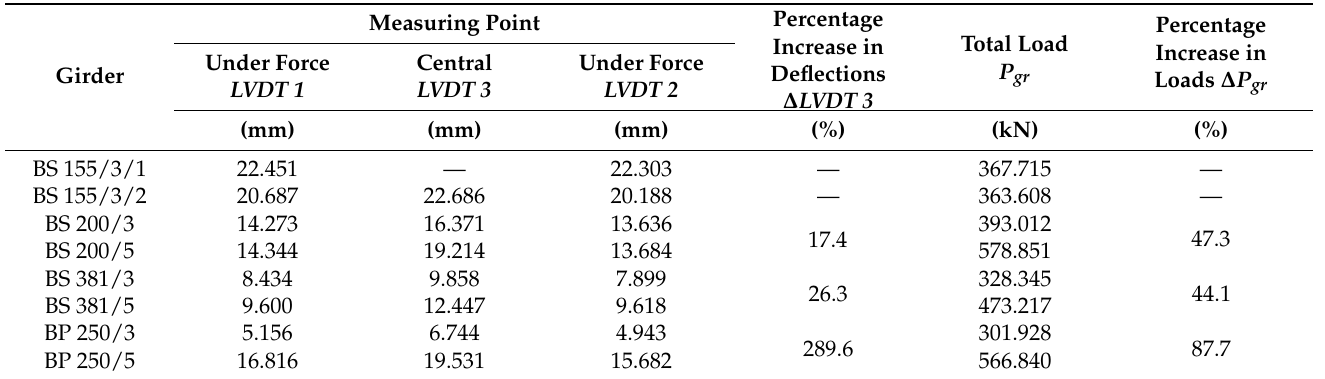
Table 4. Deflections of tested beams.